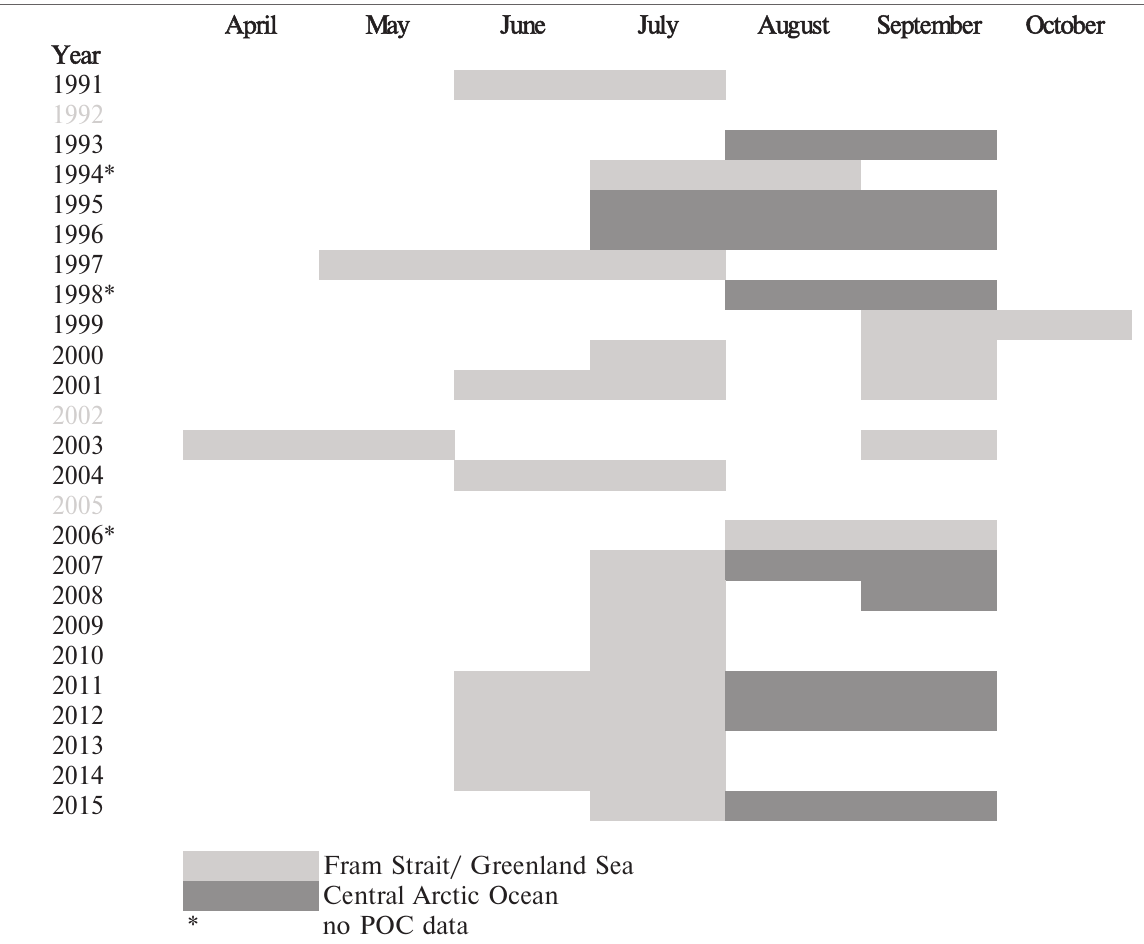
TABLE 1 | Bar chart of location and sampling month covered between 1991 and